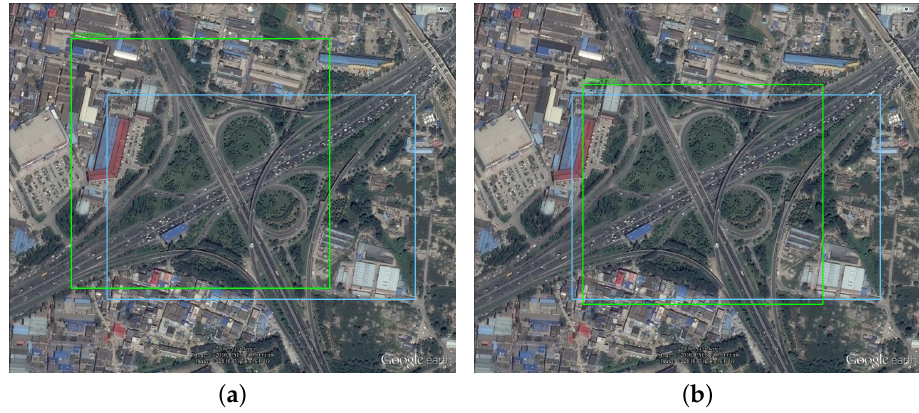
Figure 8. Comparison of detection results of YOLOv4-Tiny with the proposed detector. The ground truth is in blue box, and the predicted target is in green color. ( a ) Original YOLOv4-Tiny network detection results. ( b ) The proposed algorithm detection results.